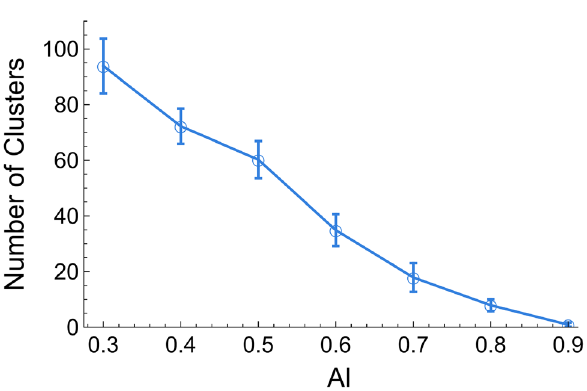
Figure 7. Number of clusters in Al–Ni alloys as obtained from MD simulations for different Al content (The error bars in this figure represent the standard